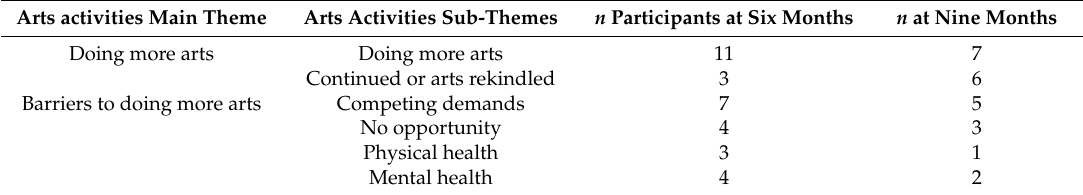
Table 10. Number of participants doing more arts or finding barriers to it at